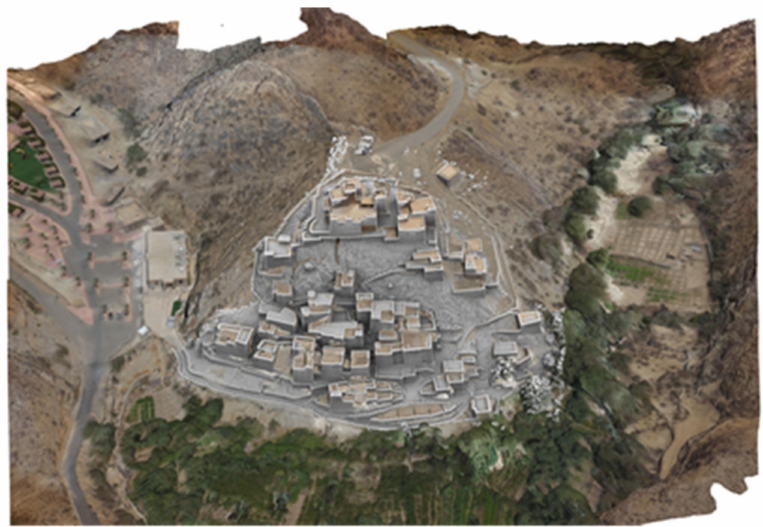
Figure 14. Data fusion, UAV textured model with TLS point cloud